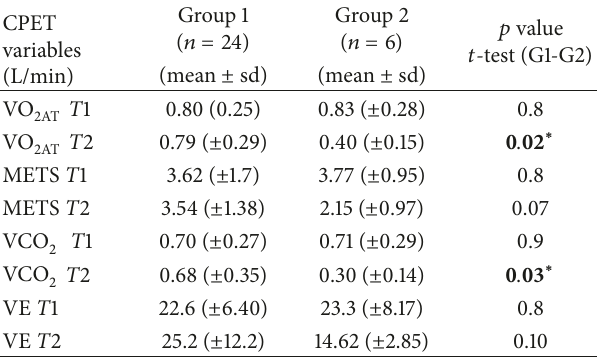
Table 4: Cardiopulmonary exercise testing measurements at the anaerobic threshold (AT). 𝑇